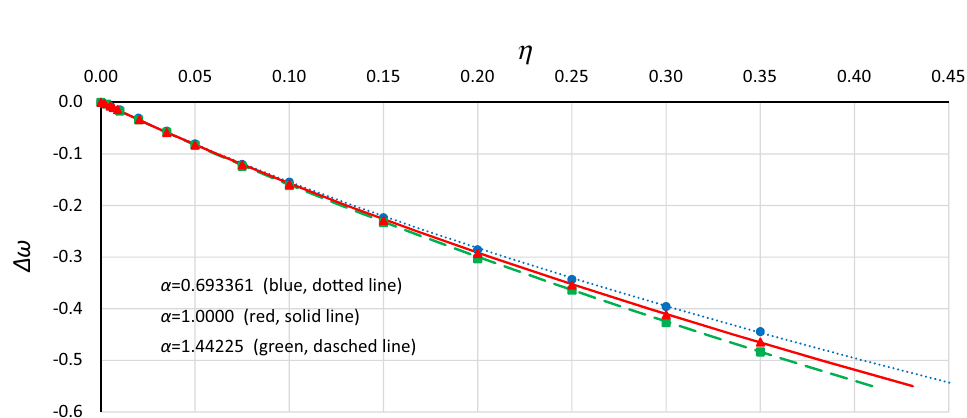
Figure 17. Comparison of the frequency changes of the origin point P B due to damping obtained from numerical simulations (markers) and on the basis of formula (16)